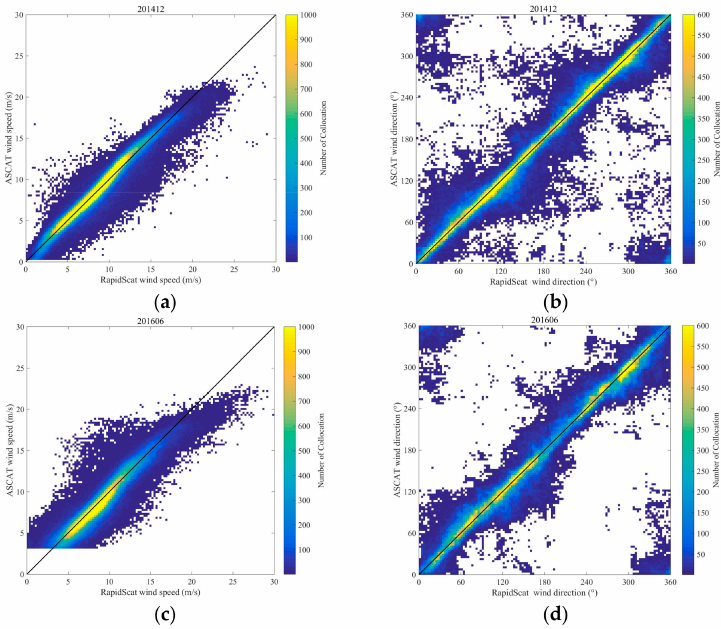
Figure 9. Scatterplots for wind speed and direction of the comparisons between RapidScat and ASCAT in December 2014 and June 2016. ( a ) wind speed in December 2014; ( b ) wind direction in December 2014; ( c ) wind speed in June 2016; ( d ) wind direction in June